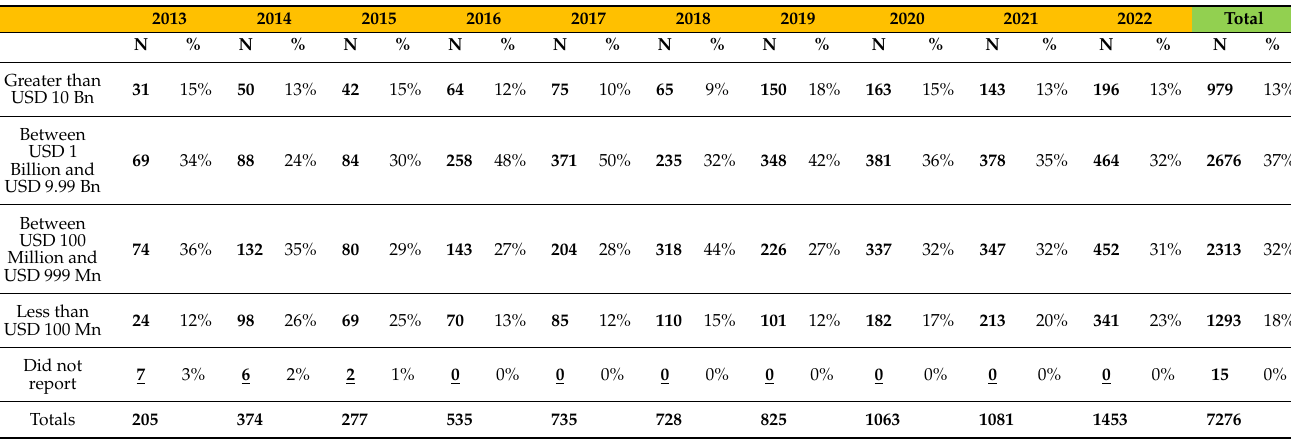
Table 3. Sample by Firm Size (Total Revenues in